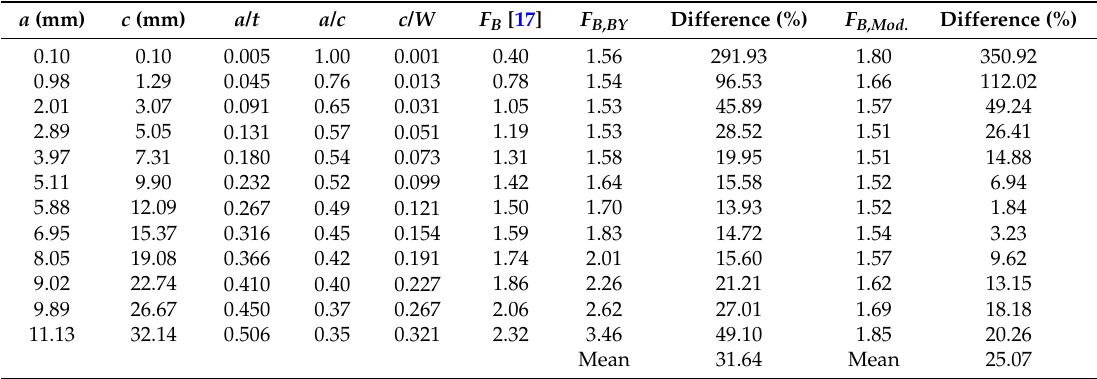
Table 6. Comparison of the dimensionless stress intensity factor values from the Baik-Yamada formula, the modified formula and the literature results by the three-dimensional finite element method at point B .